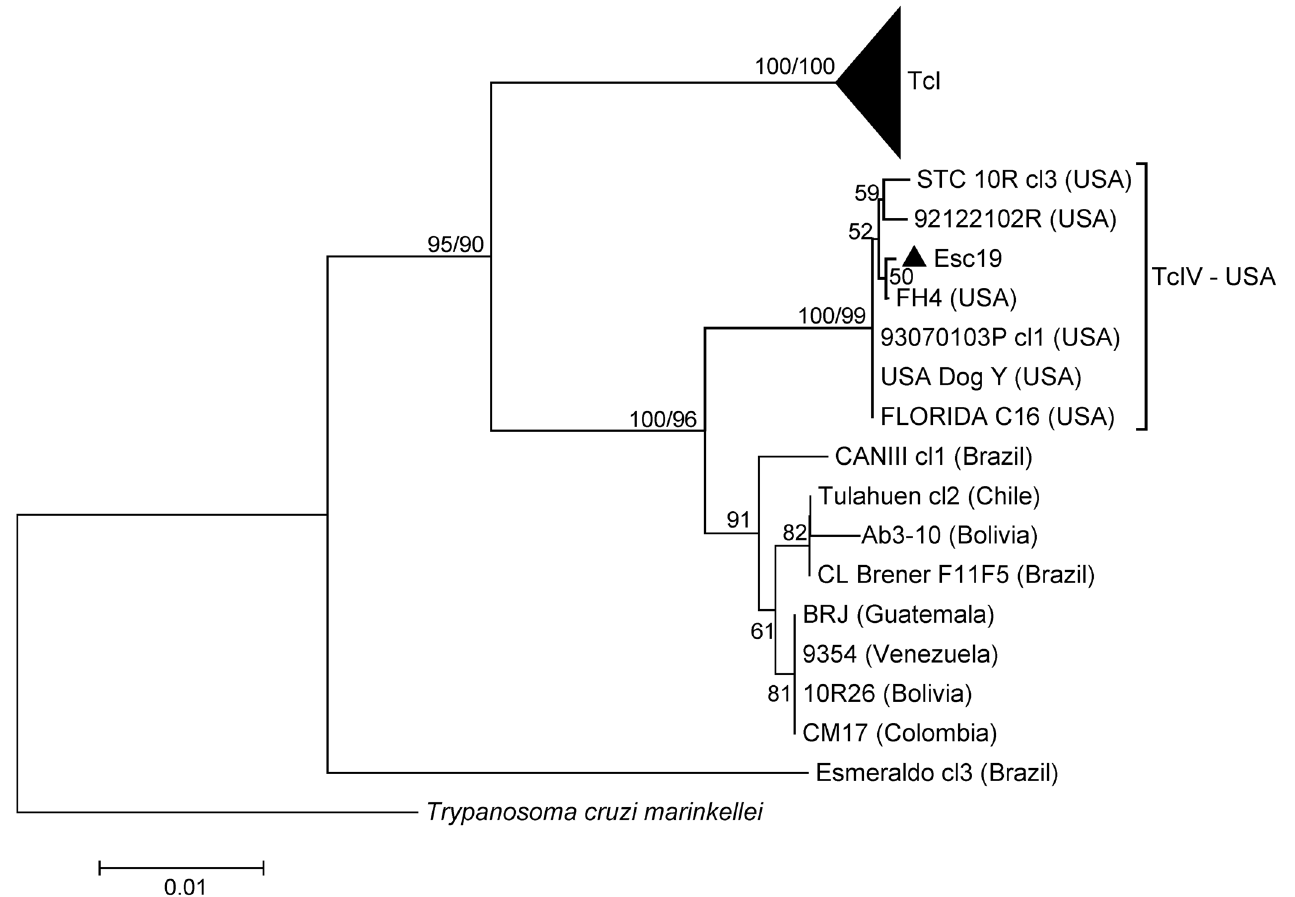
Fig 4. Phylogeny for 62 Trypanosoma cruzi concatenated 786 bp cytochrome oxidase II-NADH 1 ( COII-ND1 ) sequences. The TcI clade is condensed in this figure and contains the majority of the sequences obtained in this study (see Fig 5 for expanded version). Depicted is the Neighbor-Joining (NJ) tree constructed in MEGA6 with evolutionary distances computed via the Maximum Composite Likelihood method and the scale bar indicating the number of nucleotide substitutions per site. The numbers above or below the nodes represent the bootstrap confidence levels for 2,000 NJ replicates (1 st value) and 500 Maximum Likelihood replicates run under the Tamura 3-parameter model (due to slightly incongruent topology, ML bootstrap values are only shown at three nodes) for those values (cid:1) 50%. Only one sequence obtained in this study (Esc19 = Escondido 19) was grouped as TcIV based on mitochondrial gene sequences. All other isolates represent published GenBank sequences as listed in S1 Table with their country of origin indicated in parentheses. Tree is outgroup rooted with T . cruzi marinkellei (GenBank #AF359054).